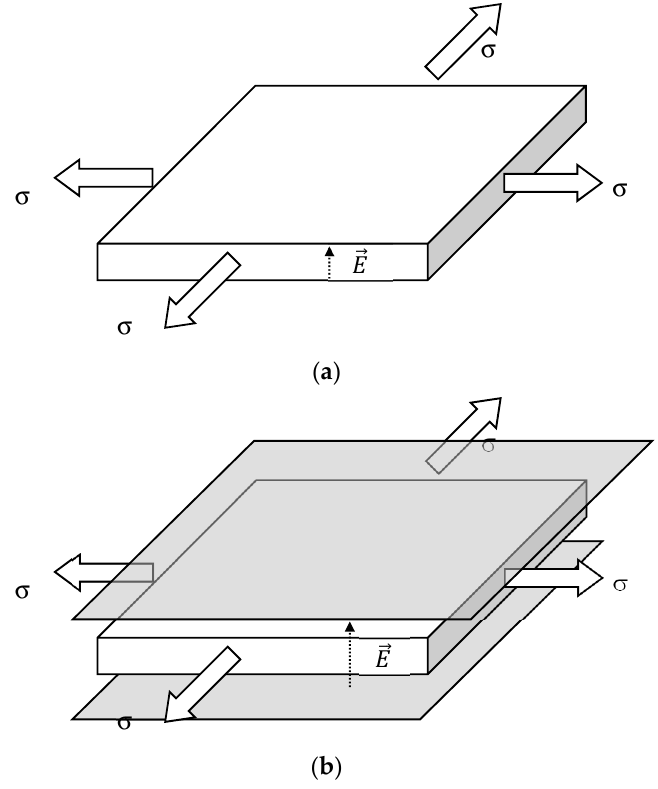
Figure 5. Geometric configuration of ( a ) sample with compliant electrode and ( b ) floating sample.